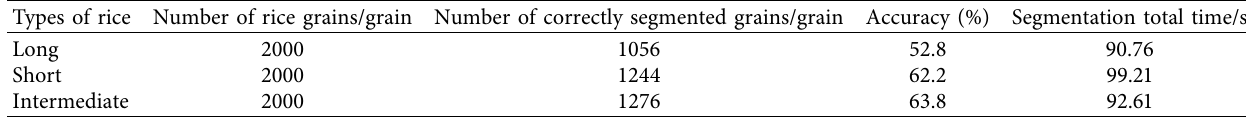
Table 3: The edge detection algorithm segmentation result.